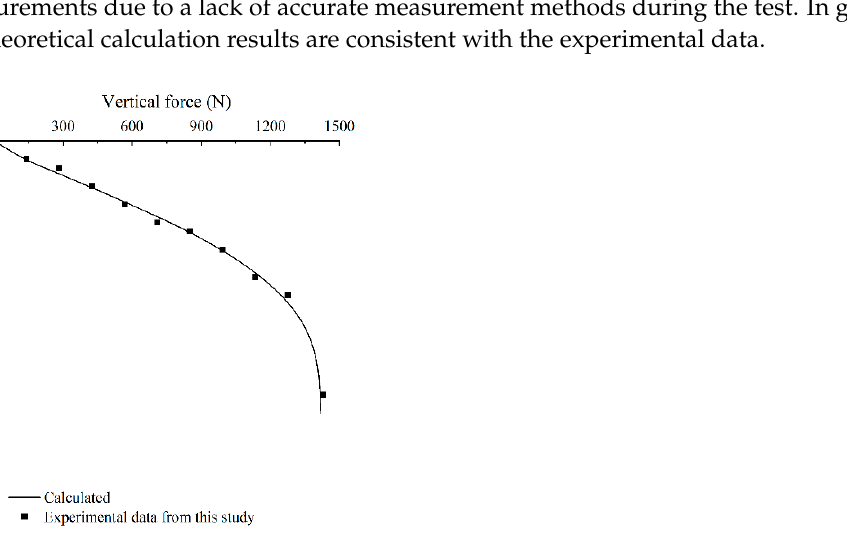
Figure 9. Comparison of Vertical force–new displacement curves at pile top and the experimental data of this study. data of this